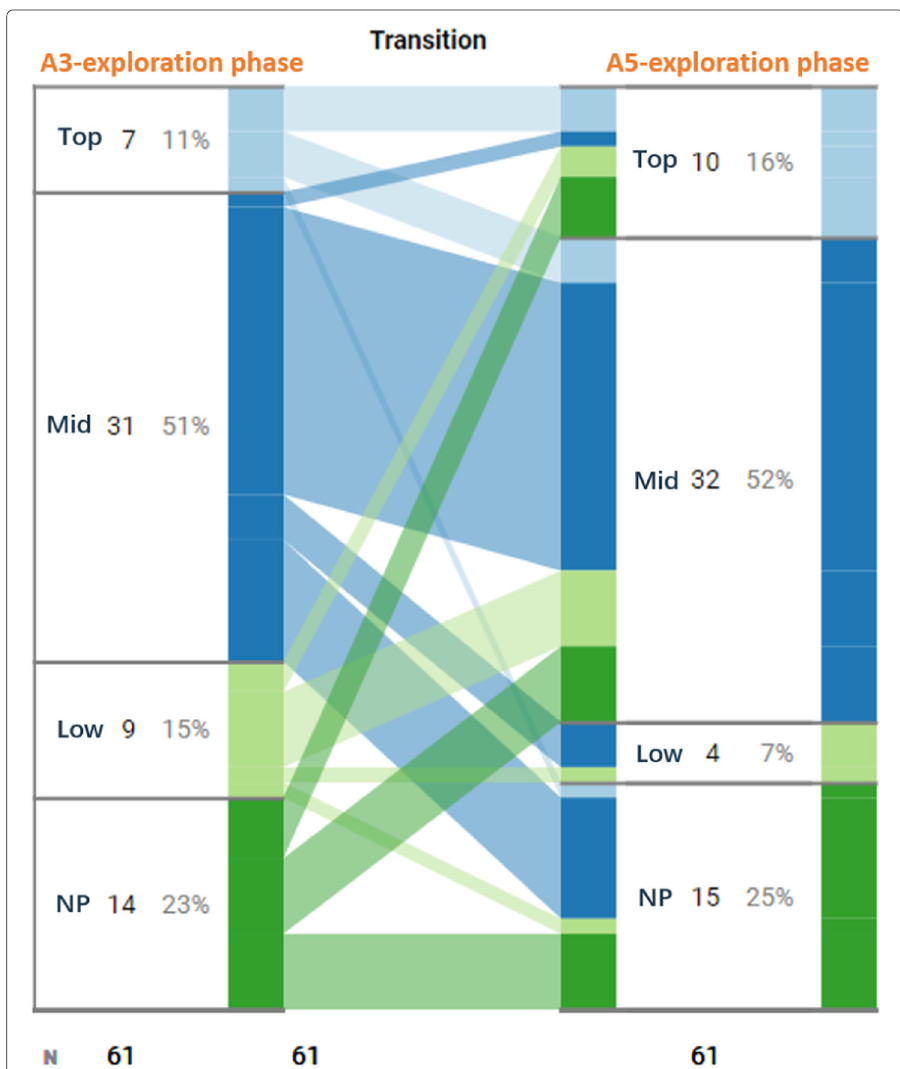
Fig. 12 Transition patterns of utterance duration for knowledge exploration phase activity between activity A3 and A5